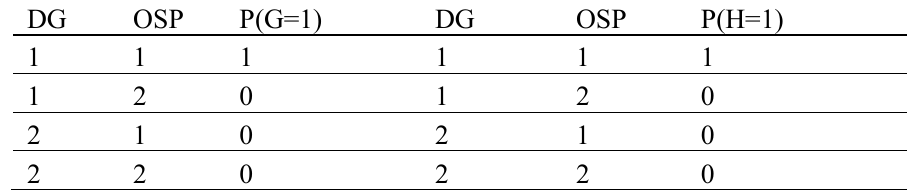
Table 9. States related to nodes G and H